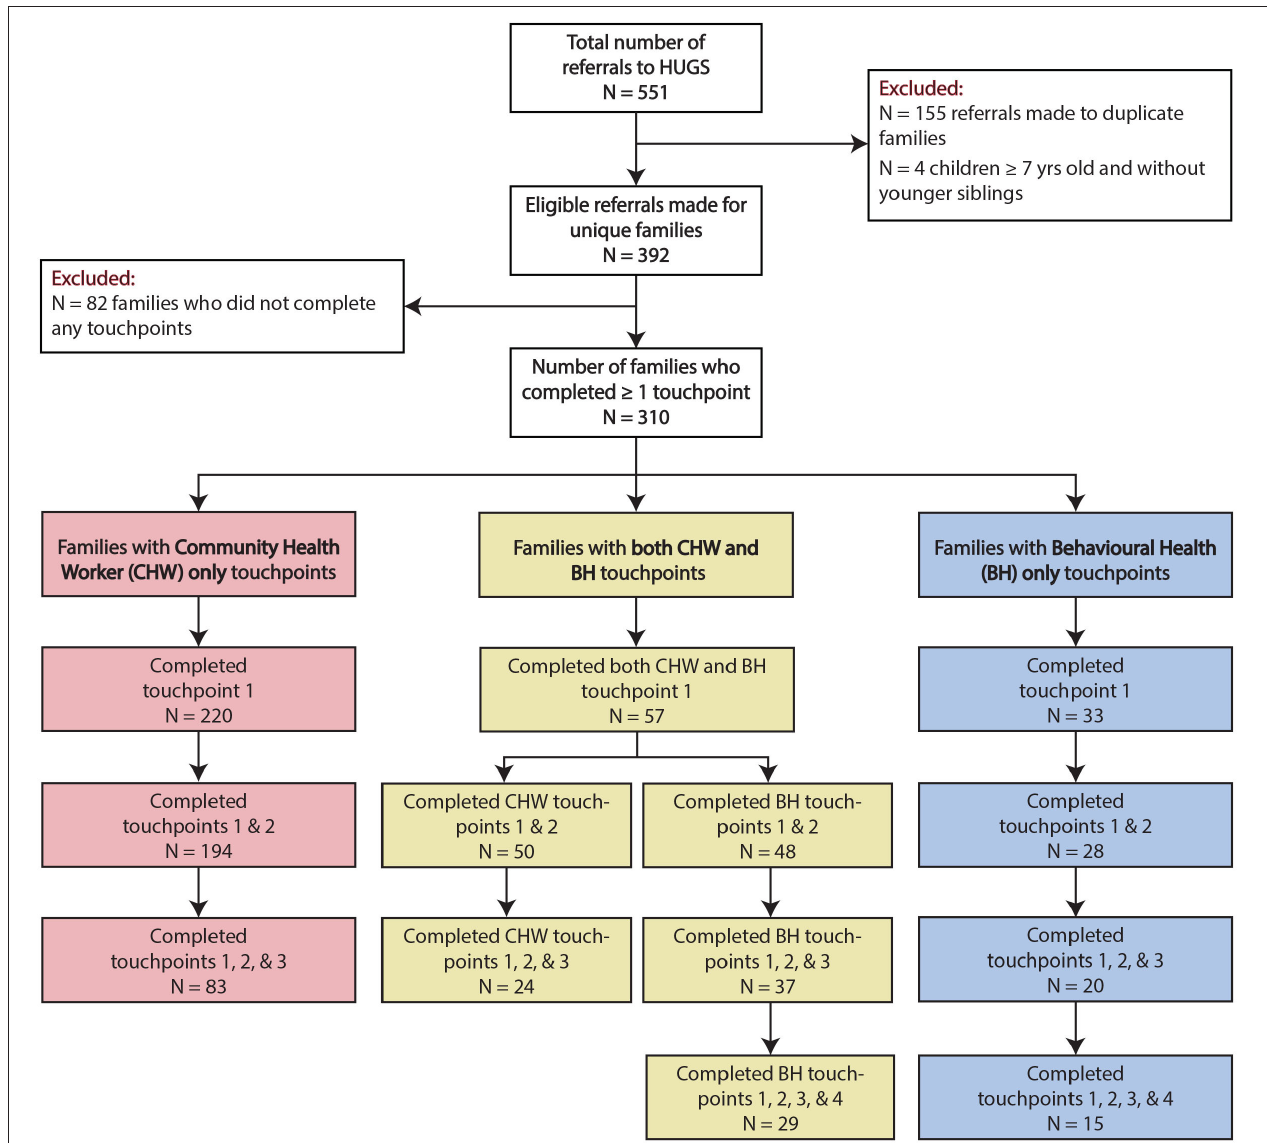
FIGURE 1 | Flowchart of referrals to the HUGS/Abrazos Program (6/30/2020–8/31/2021). Patients can complete up to three touchpoints with the community health workers or up to four touchpoints with the behavioral health